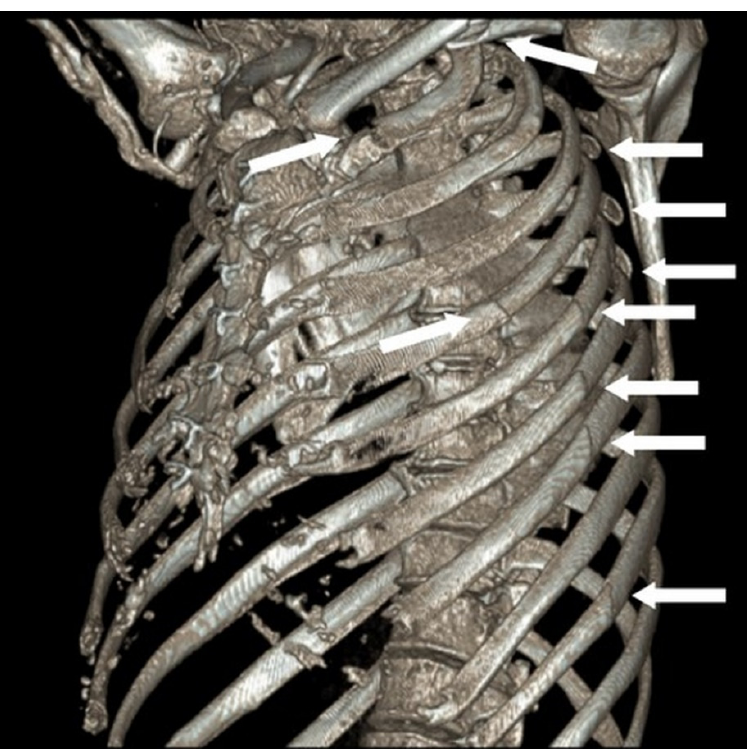
Figure 2. Preoperative 3-dimensional CT reconstruction of chest. Preoperative 3-dimensional CT reconstruction of chest—white arrows point to fracture sites.